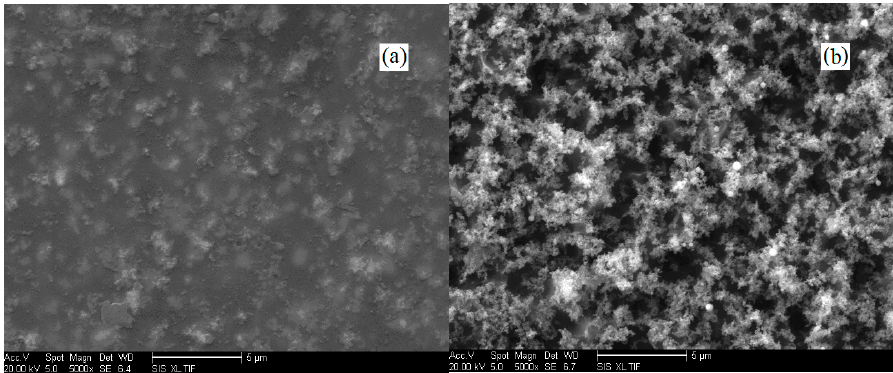
Figure 7. SEM morphologies of the PI/TiO 2 composite films ( a ) before and ( b ) after the corona